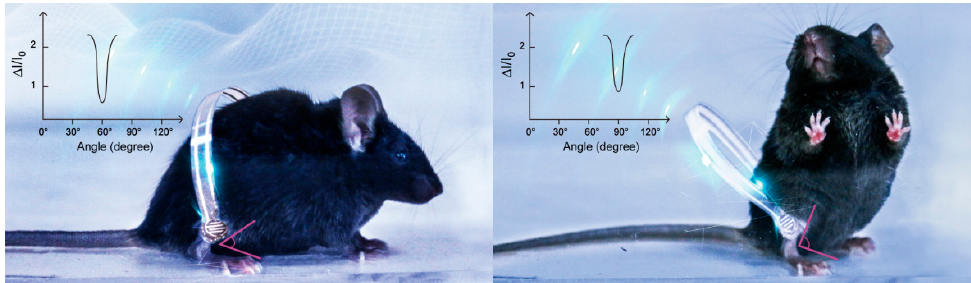
Figure 1. Schematic diagram of the flexible pressure sensor attached to the legs of mice for full-range and real-time detection of their behaviors.